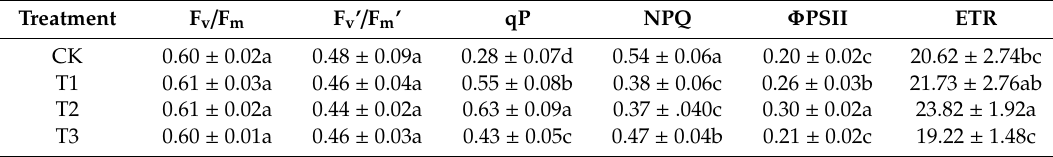
Table 1. E ff ects of exogenous ALA application in the substrate on chlorophyll fluorescence parameters of cucumber seedlings under low-temperature and weak-light stress. Treatment